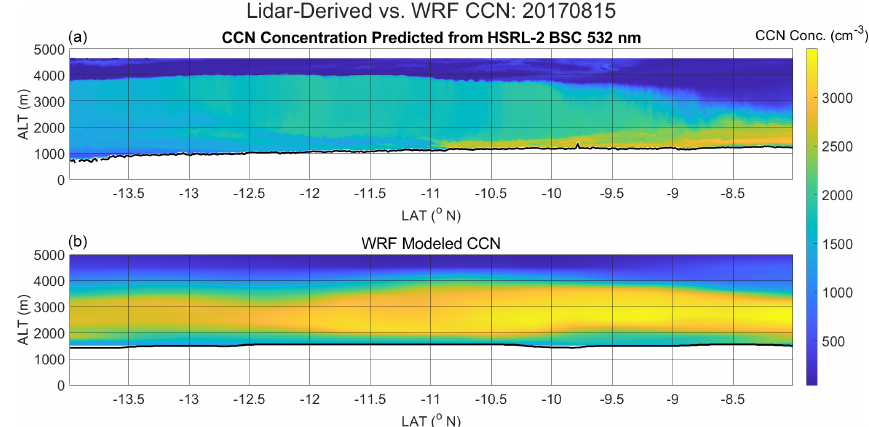
Figure 9. (a) Derived curtain of CCN concentrations from the HSRL-2 backscatter coefficient at 532nm for an ORACLES P-3 track on 15 August 2017. The black line corresponds to HSRL-2 cloud top height altitudes. (b) WRF-CAM5 model CCN curtain corresponding to the same P-3 track. The black line corresponds to the nearest HSRL-2-interpolated altitude at WRF-estimated cloud top